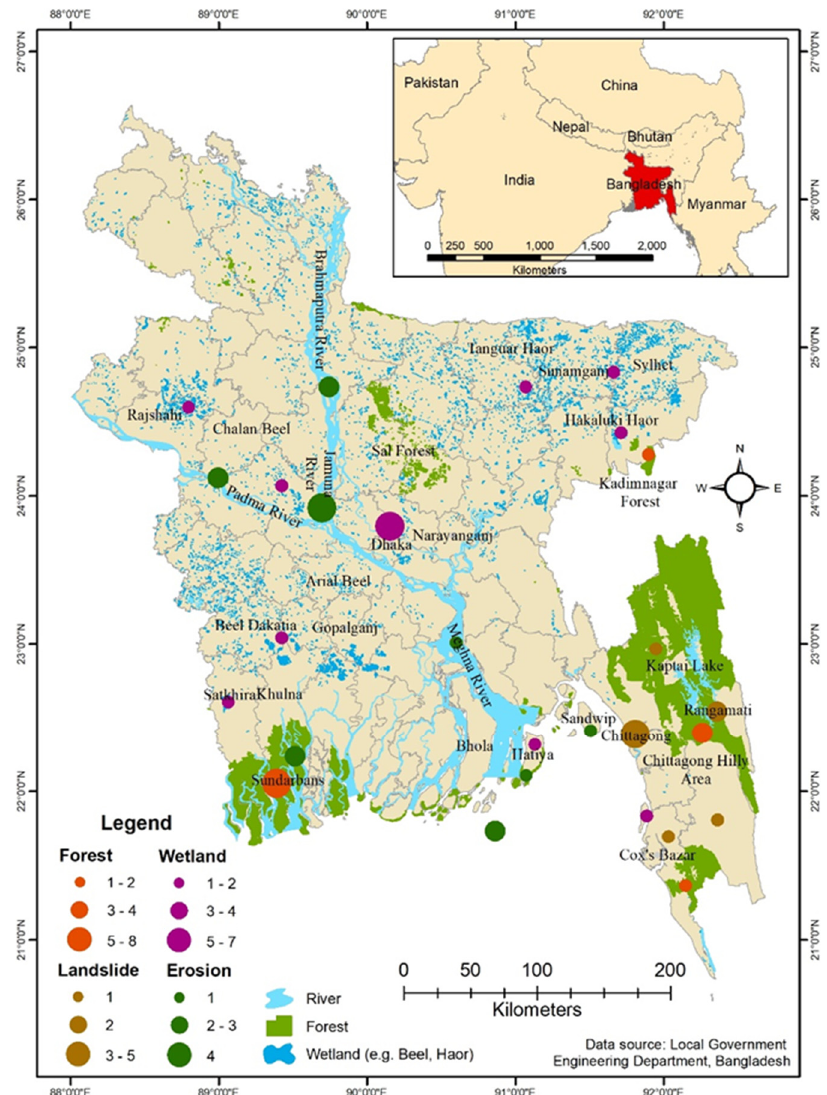
Figure 10. Geographical coverage of the research articles published on forest, wetland, erosion, and landslide related issues in Bangladesh.